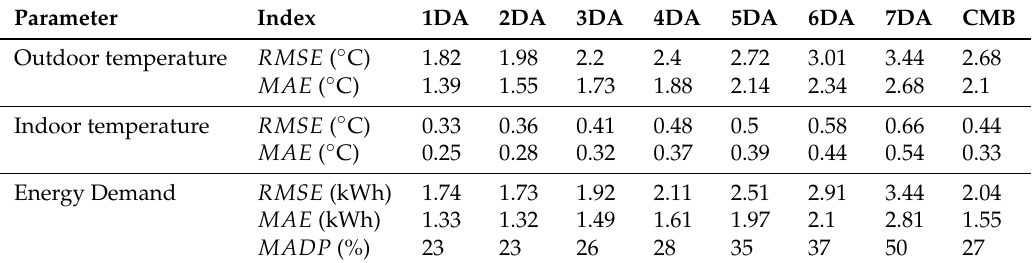
Table 2. Error metrics for forecast hourly outdoor temperature, mean hourly indoor temperature